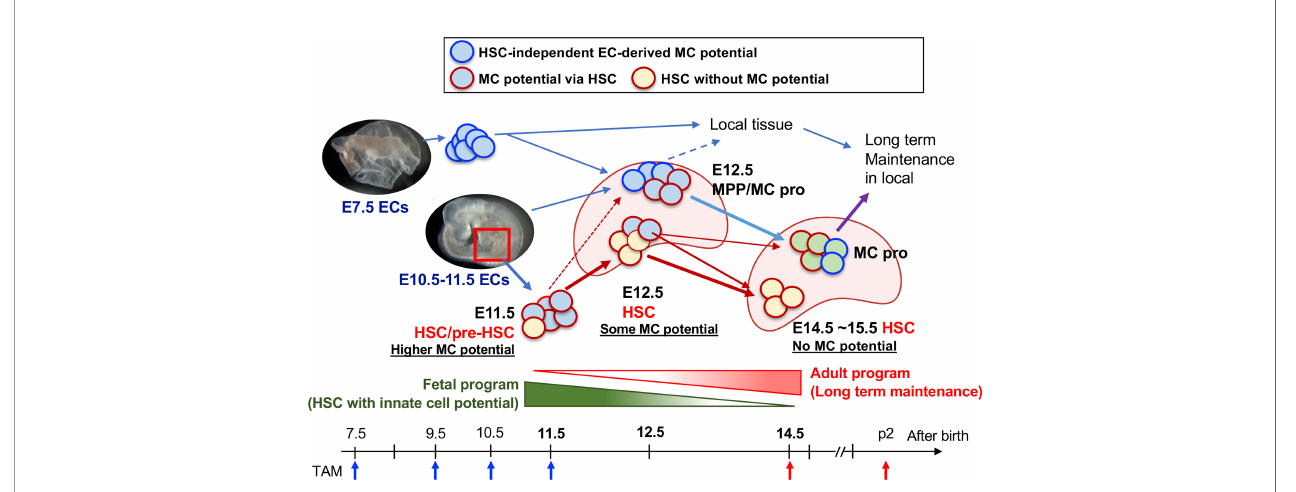
FIGURE 5 | Diversi fi cation of HSC to the MC progenitor and HSC maturation. E10.5 – 11.5 pre-HSC in the AGM region contains a variety of cell populations including HSC with MC capacity (plus other innate lineages too), MPP, and other lineage-restricted progenitors. E12.5 FL contains at least 3 classes of MC repopulating cells; 1) HSCs (with reduced MC differentiation capacity), 2) MPPs with MC potential, and 3) Kit + b 7-integrin + MC progenitor cells. 1) is the consequence of E11.5 pre-HSC/HSC and 2) are derived from E9.5-10.5 AGM EC-derived production. 3) are derived from the early EC-derived wave and later AGM EC wave. In E14.5, HSCs had lost MC capacity, but MC progenitors still exist within MNCs, then distribute into general tissue and maintain long term in